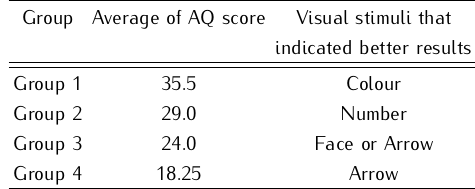
Table 4. The summary for the visual stimuli tests.